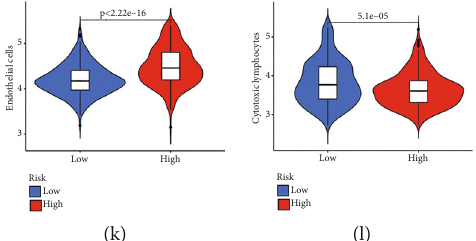
Figure 6: Immune feature di ff erences between the high-risk group and the low-risk group. (a, b) GSEA was used to evaluate the di ff erence in the enrichment of KEGG between the high-risk group and the low-risk group. (c – l) MCP counter was utilized to evaluate immune cell in fi ltration di ff erence between the high-risk group and the low-risk